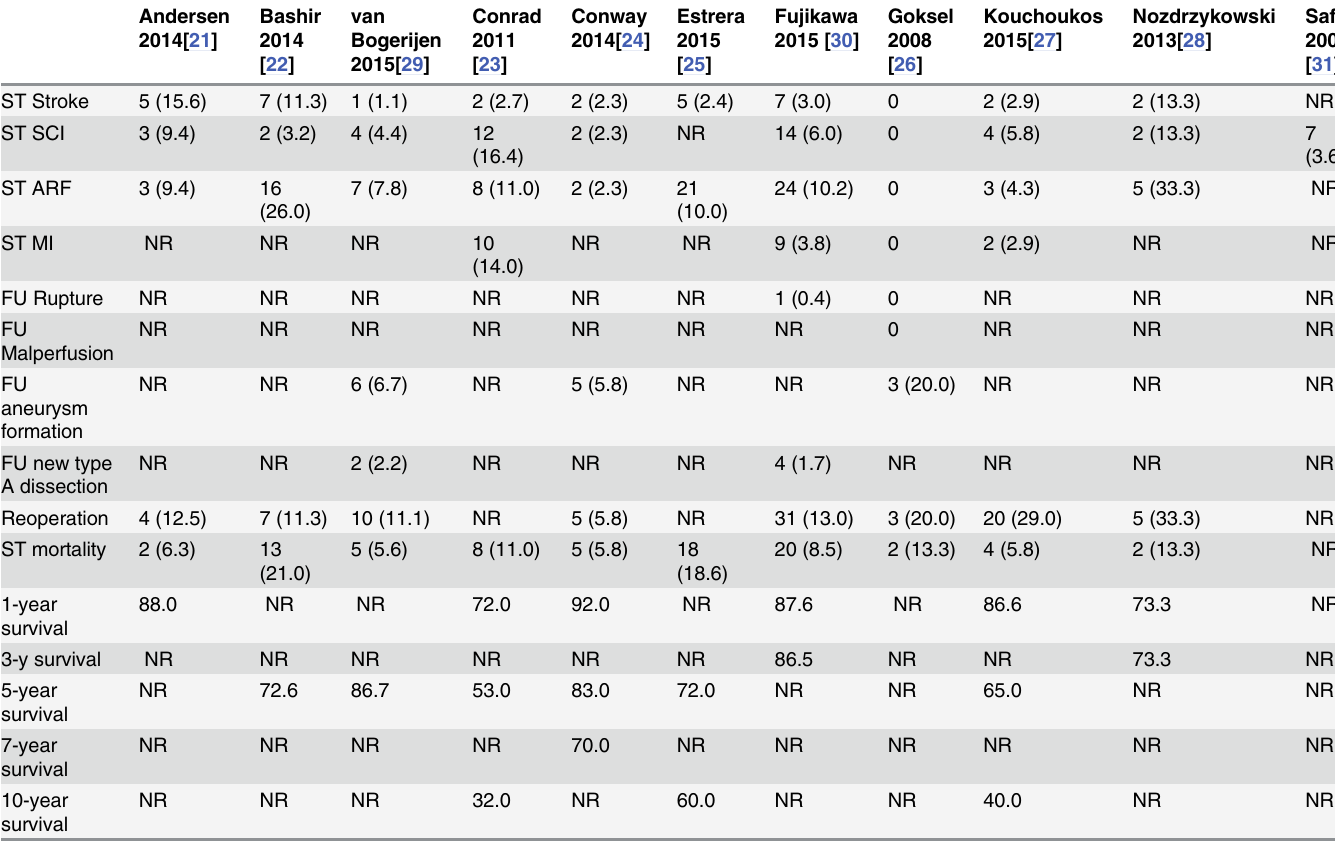
Table 1. Complications and survival